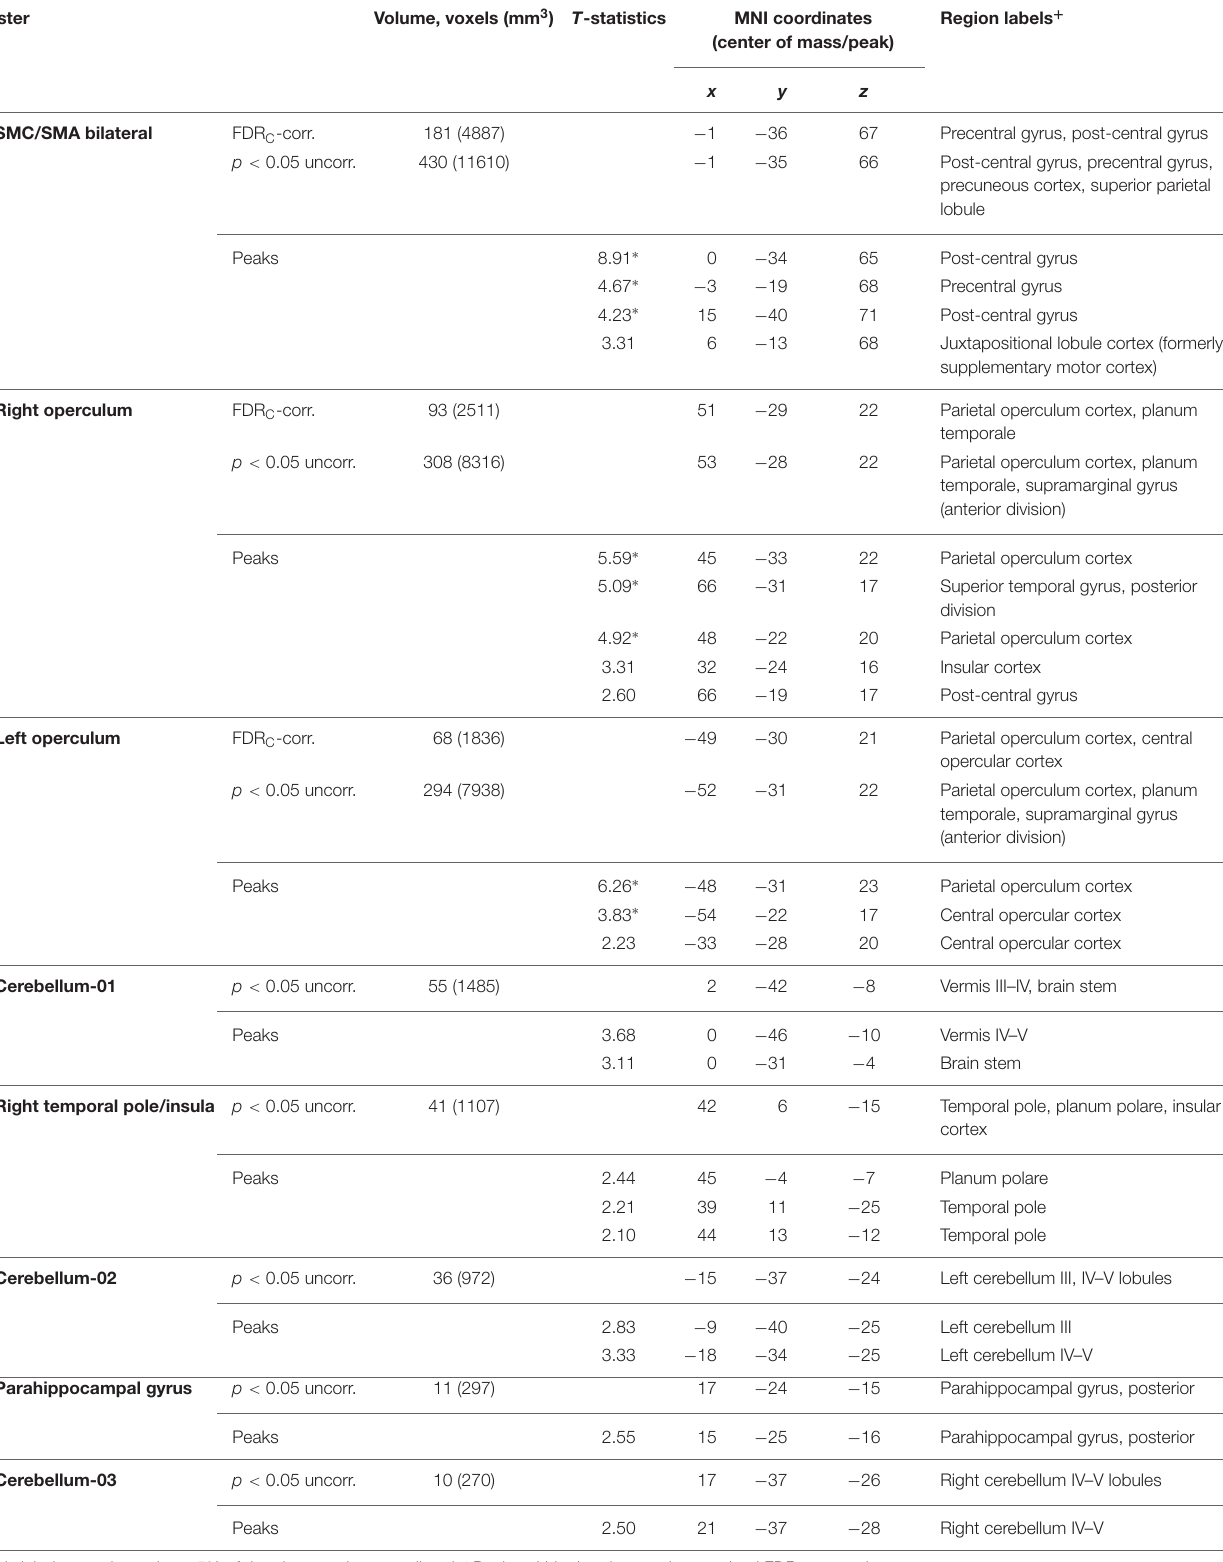
TABLE 3 | Clusters of activation revealed by the plantar stimulation in all participants.